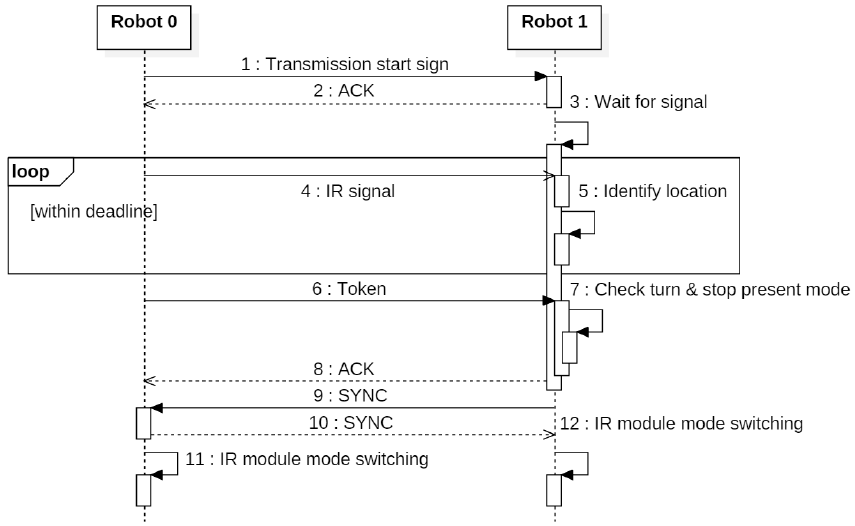
Figure 7. Sequence diagram for sequential IR signal transmission using a token.